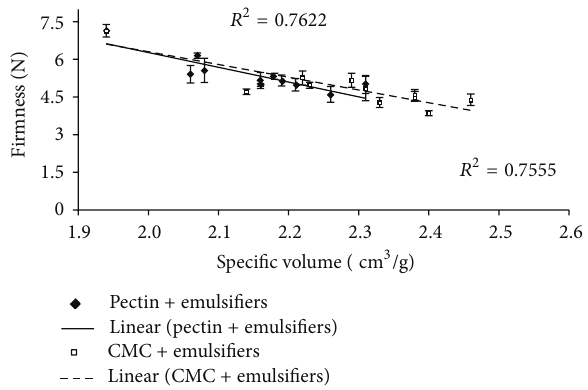
Figure 2: Correlation between firmness of the composite bread crumbandthespecificvolume.Theerrorbarsrepresentthestandard